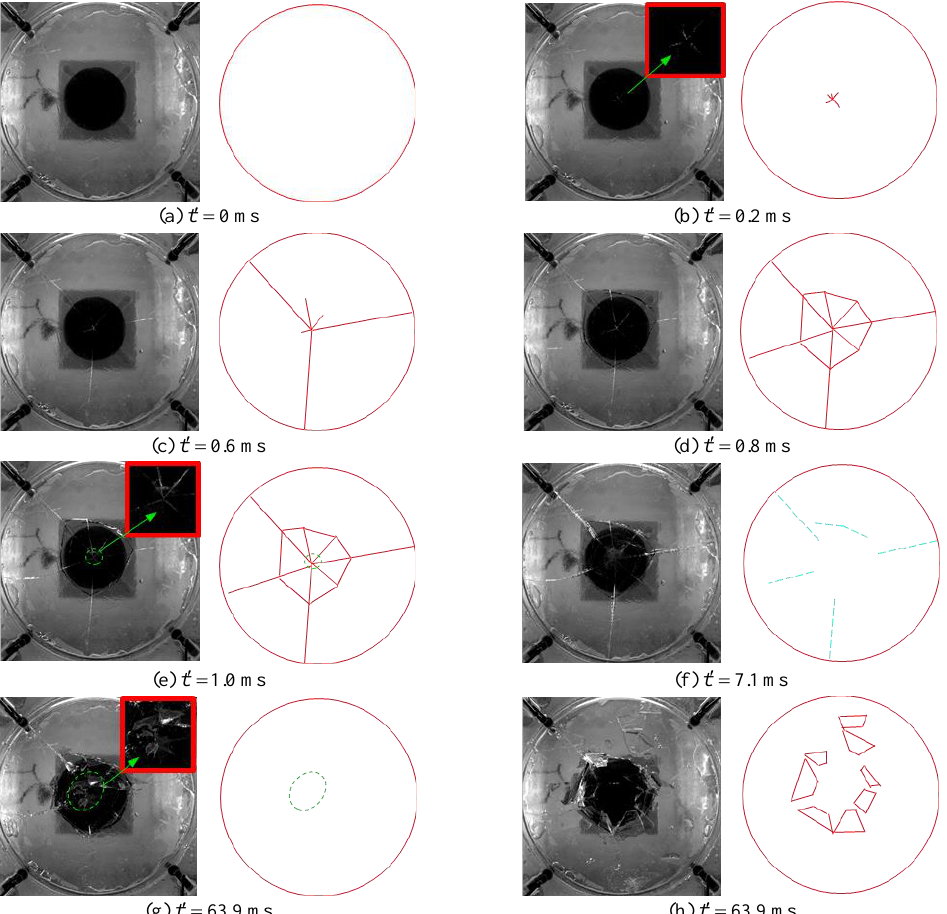
Figure 8. The breaking process of the ice plate under the impact of the buoyant sphere at different moments, as denoted in the subfigures, for the case = 0.4, 0 L = 2.31 and h = 0.089. In order to intuitively explain the cause of the destruction of the ice plate after the impact, Figure 9 is demonstrated. As shown in Figure 9a, when the sphere collided with the ice plate, a compressive wave before a tensile wave was transmitted from the collision point. When the compressive wave arrived and was reflected by the upper surface of the ice plate, it became a tensile wave due to the acoustic impedance of the different media on both sides of the interface. Because the tensile strength of the ice (about 2.2Mpa at − 5°C) is much lower than its compressive strength (about 9.4Mpa at −5°C), ice is more fragile under tensile waves compared with compressive waves [27]. Especially, when the re- flected tensile waves encountered and interacted with incident tensile waves, as shown in Figure 9b, the ice plate became very fragile, as shown in Figure 9c. As a result, the ice plate broke up in spalling, leaving sloped fractures, as shown in Figure 9d. In fact, there may be more forms of wave transmission, such as shear or Rayleigh waves, whose effects com- plicated the destruction of the ice plate [64]. However, due to the limited shooting equip- ment, it was hard to record the wave propagation in ice accurately.